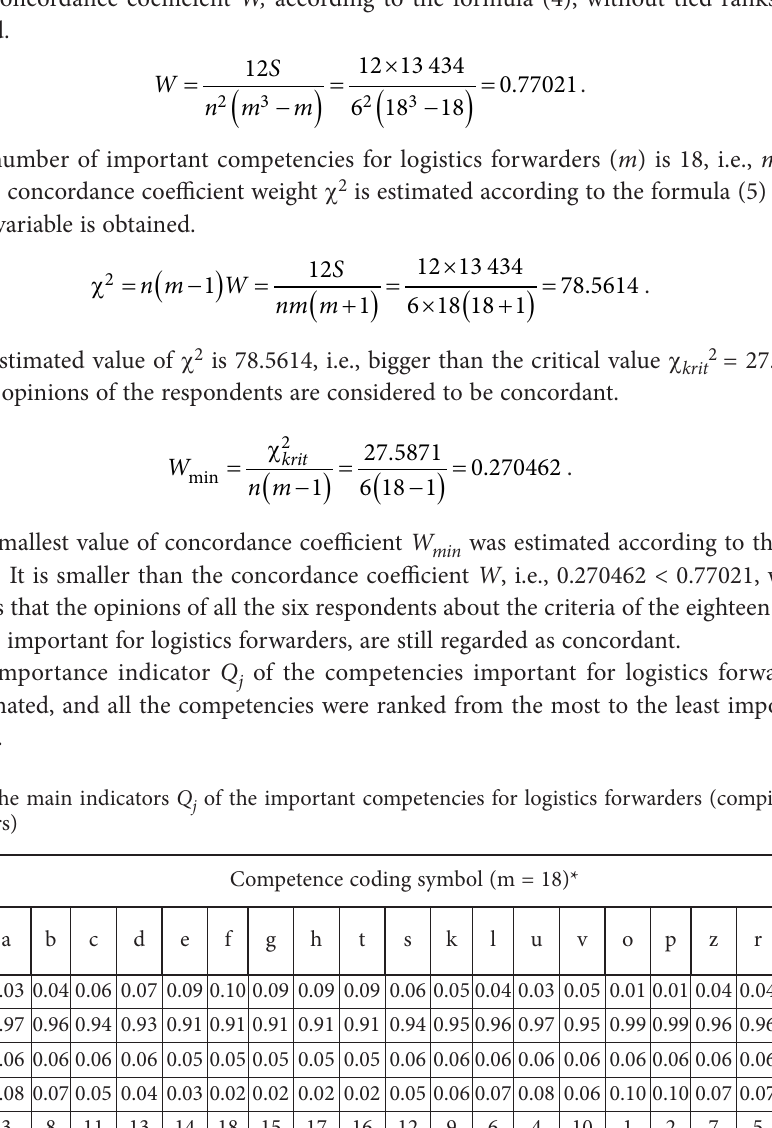
Q j ′ Ranks 3 8 11 13 14 18 15 17 16 12 9 6 4 10 1 2 7 5 Note : Competence coding*: a – look for potential clients and establish contacts; b – identify needs of cli- ents; c – present offered logistics and transport services in an official and foreign languages; d – employ office equipment in activities; e – accept and store goods; f – account for goods; g – prepare criteria for selection of carriers; h – prepare criteria for selection of means of transport; t – prepare criteria for selection of freight; s – select suitable transport for carriage of goods; k – set optimal transportation route; l – estimate total transportation time, fuel consumption and route profit; u – use geographical information systems; v – use transport tracking software; o – use logistical information systems; p – use modern general information systems; z – provide information as to issues related to traffic direction, need for transport maintenance, transportation of goods and related documentation; r – submit goods for customs’ clearance and